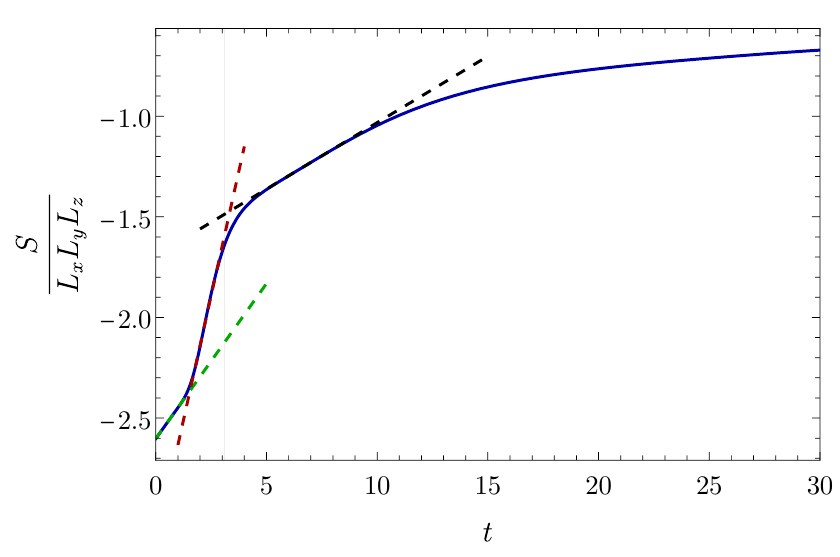
Figure 12 . Total entropy normalized by the volume as a function of time for an neutral oblate blob collision with δx = 2 . The dashed lines correspond to linear fits, whose slopes are (0 . 1541 , 0 . 4945 , 0 . 0660) . The first change in the slope takes place at t ≈ 1 . 5 , while the vertical gray marks the collision time t 3 . 11 . c ≈